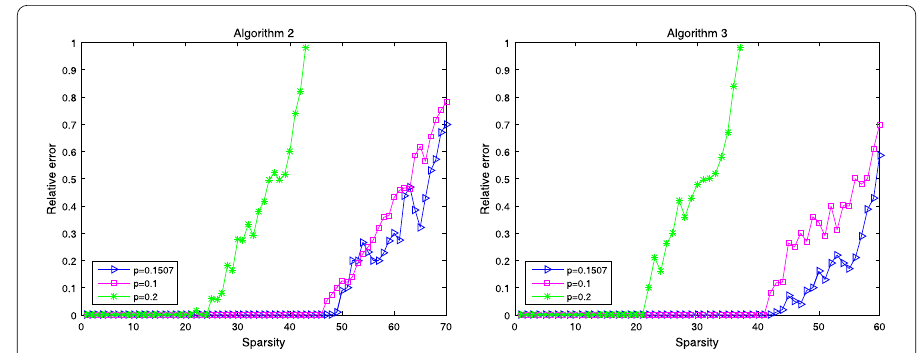
Figure 6 The performance of Algorithm 2 and Algorithm 3, Algorithm 2 is the left one and Algorithm 3 is the right